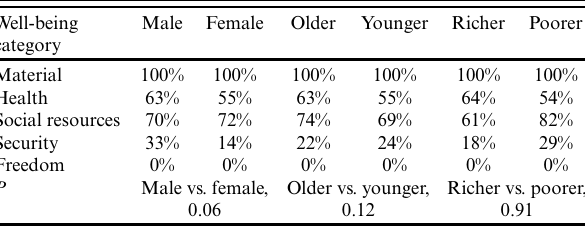
Table 6. Frequency of components named in individual interviews by demographic subgroups, aggregated by well-being category. P - values from Pearson Chi-squared tests between demographic